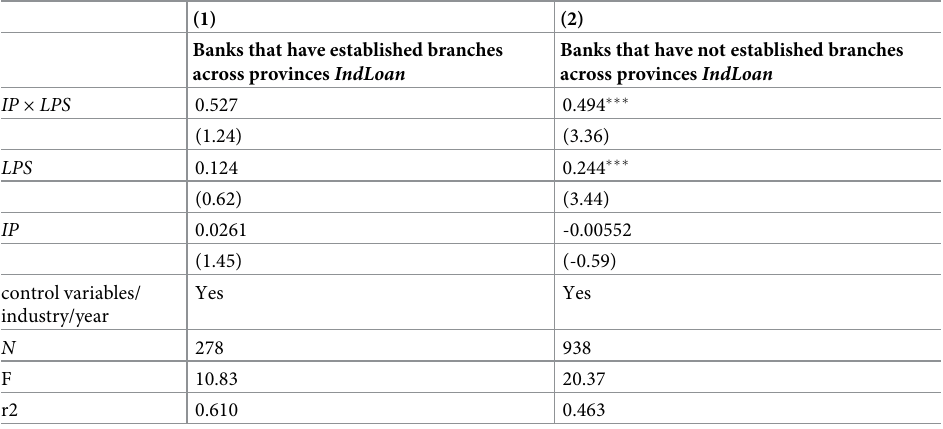
Table 5. Large private shareholders, local industrial policies and industrial loans of city commercial banks (con- sider cross-provincial operations of banks). (1) (2) Banks that have established branches Banks that have not established branches across provinces IndLoan across provinces